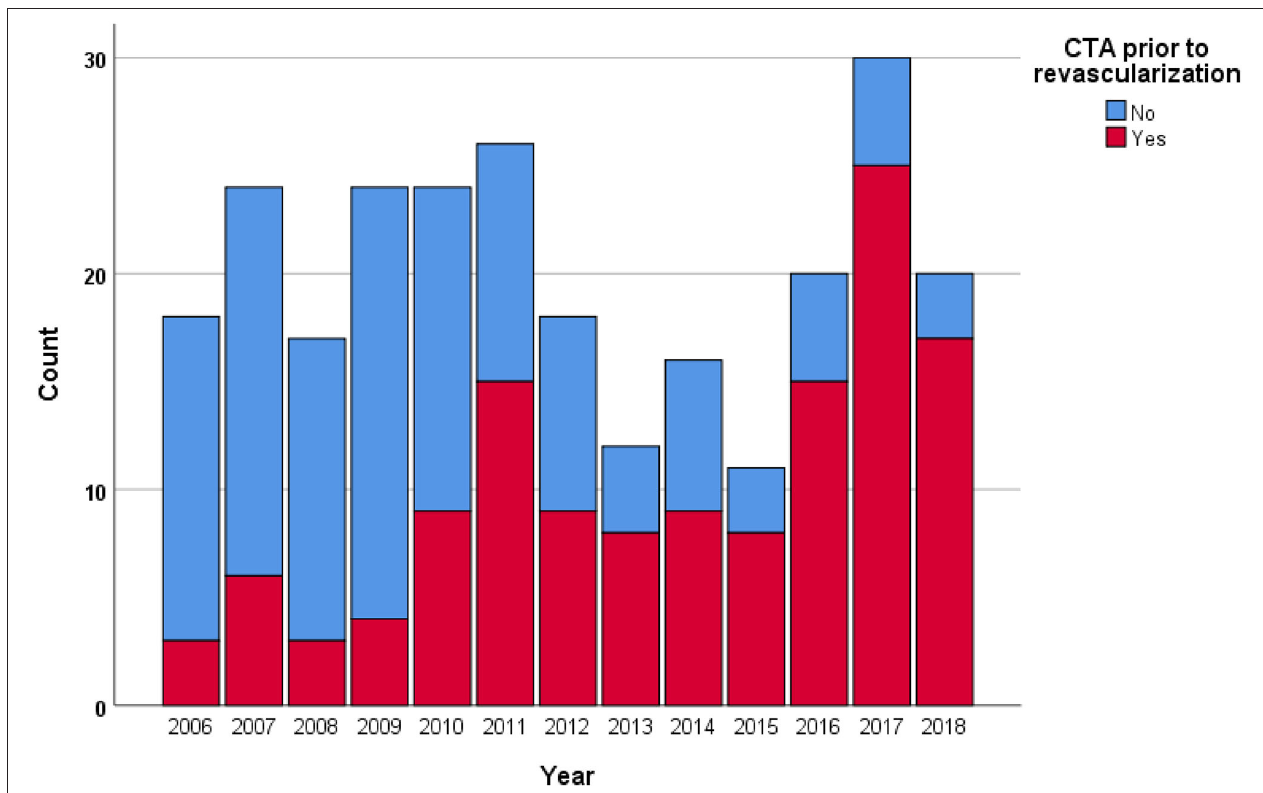
FIGURE 1 | The proportion of computed tomography angiography (CTA) prior to revascularization in Rutherford IIb ALI increased ( p < 0.001) throughout the study